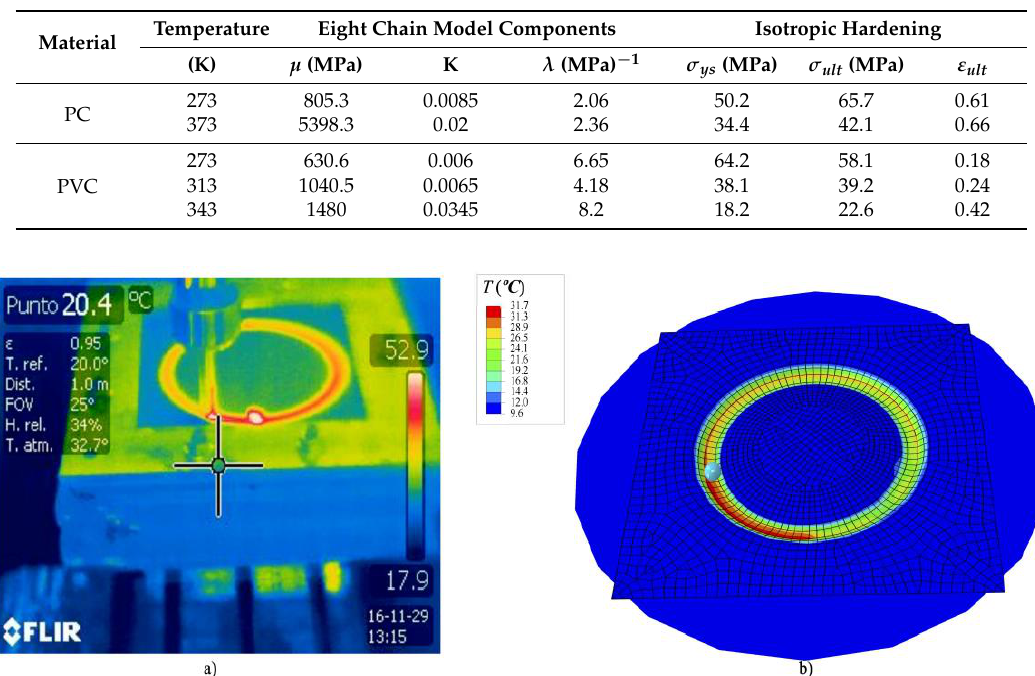
Figure 6. Temperature for a PVC sheet: ( a ) Example of experimental temperature measurements; ( b ) numerical temperature estimation.